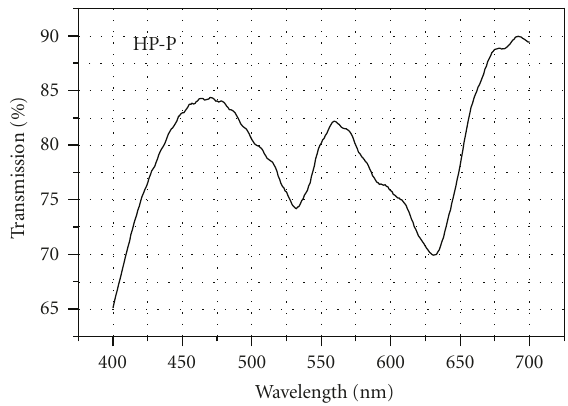
Figure 1: Transmission spectra of panchromatic silver halide light sensitive plates HP-P.